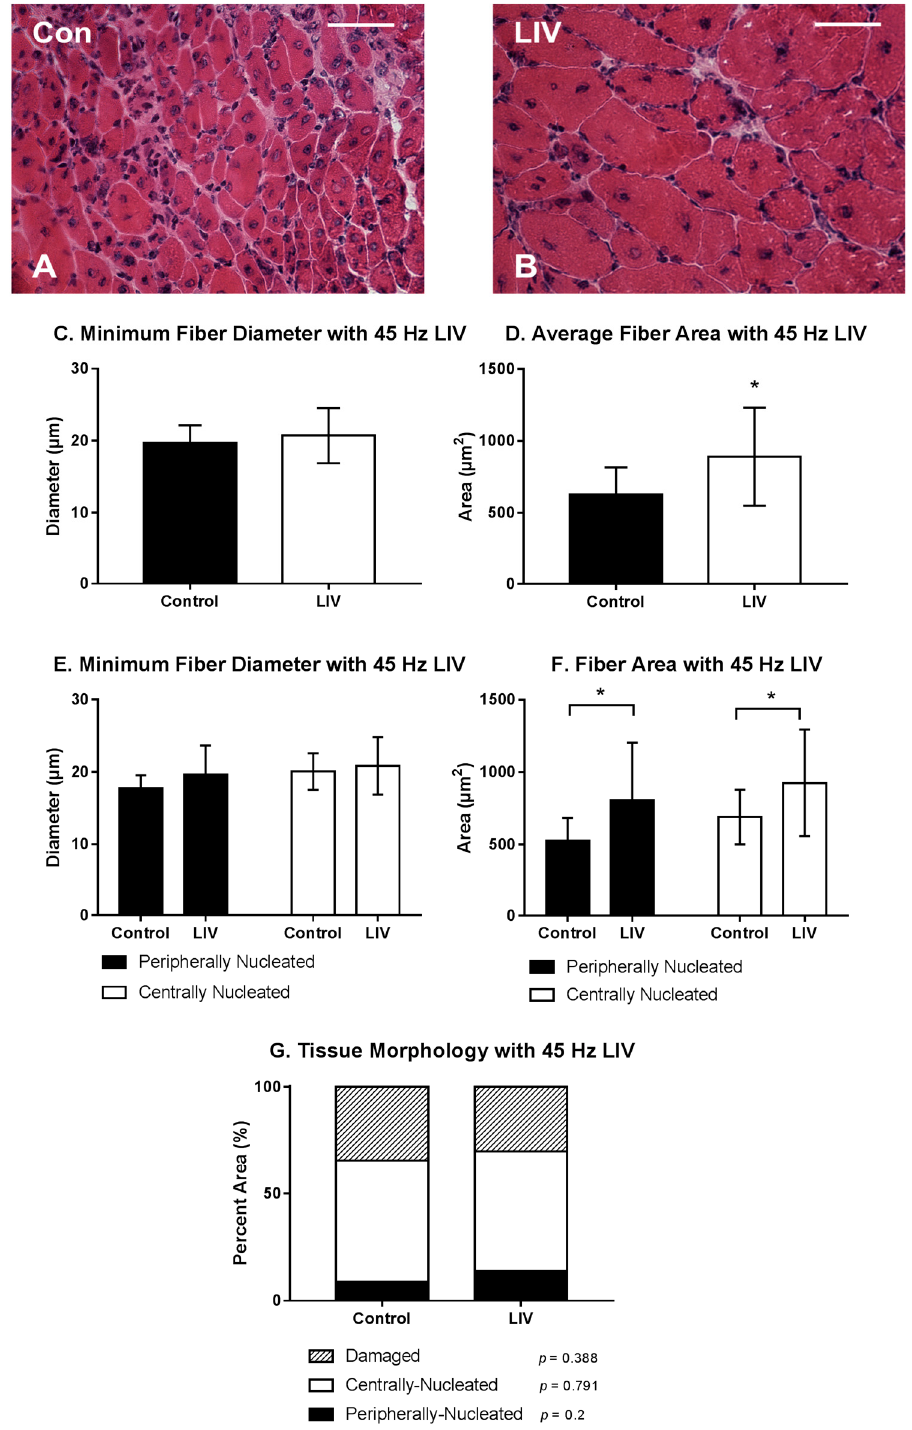
Figure 3. Low-intensity vibration (LIV) at 45 Hz and 0.4 g enhances myofiber growth following laceration muscle injury in mice at 14 days post-injury. Gastrocnemius muscles were lacerated and collected for histological analysis at day 14 post-injury. ( A , B ) Representative images of hematoxylin and eosin-stained sections (scale bar = 50 µ m, 40 × magnification); ( C , E ) Average minimum myofiber diameter; ( D , F ) average cross-sectional area of individual myofibers, and ( G ) percent area of injury that consists of peripherally-nucleated fibers, centrally-nucleated fibers, or damaged tissue was quantified in five 40 × fields per muscle in hematoxylin and eosin-stained sections; ( C , D ) All fiber types averaged together; ( E , F ) Myofibers grouped by type. Data are presented as mean ± SE. * p ≤ 0.05.